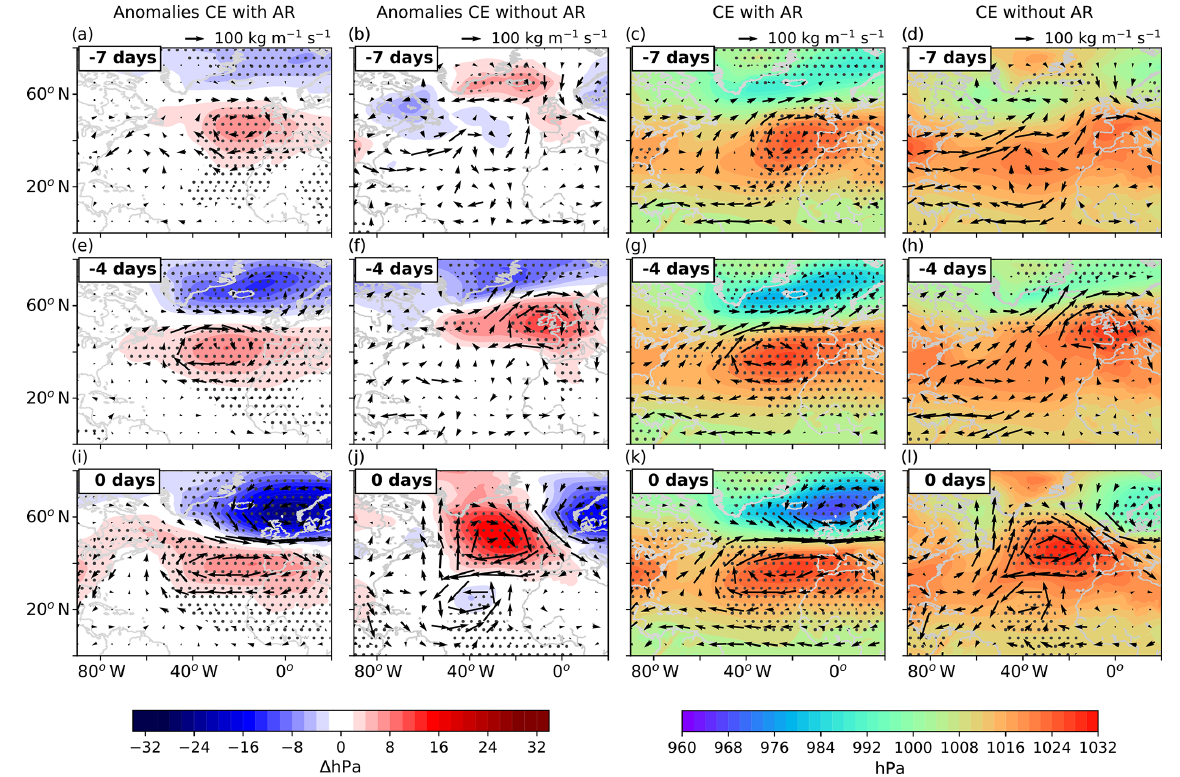
Figure 6. Temporal evolution of mean conditions 7 (a–d) and 4 days (e–h) before a CE at Den Helder and on the day of the event itself (i–l) . The left two columns, i.e. panels (a, e, i) and (b, f, j) , show the evolution of anomalies in SLP (colour shading) and IVT (vector field) during CEs with and without AR association, respectively. The right two columns, i.e. panels (c, g, k) and (d, h, l) , show the same but for absolute values of daily mean SLP and IVT. Results for the three other stations (not shown) are comparable. Stippled areas mark regions with a p value below 0.05 derived from a student t test of daily mean SLP values compared to the daily mean values of full time